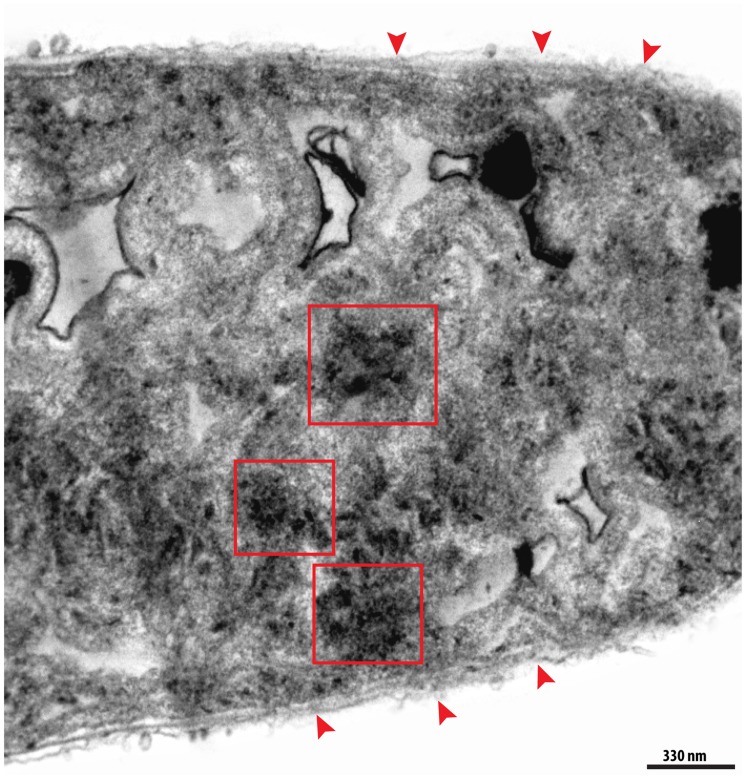
Electron micrograph of a representative degenerating cyanobacterium. In addition to a clear loss of thylakoid membranes, aggregates of dissolving phycobilisomes (red boxes) were observed in the cytoplasm. Note the loss of the integrity of the cell envelope (arrowheads).